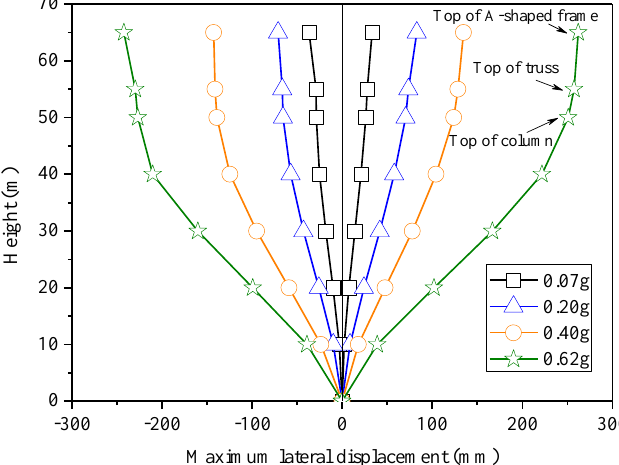
Figure 17. Maximum lateral displacements versus height curves subjected to different hazard levels.